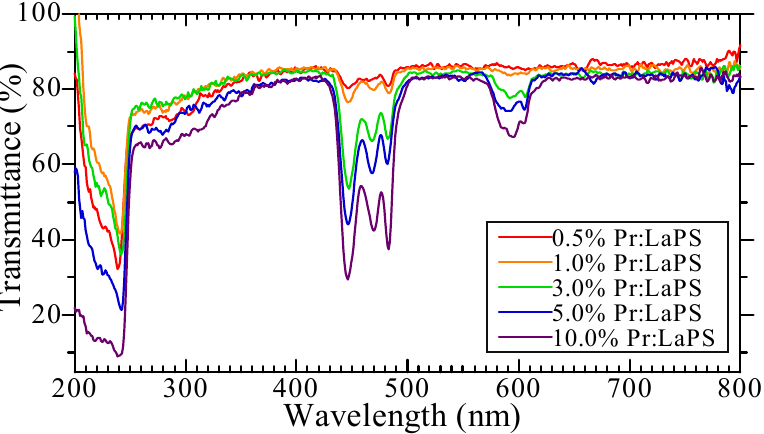
Figure 3. Transmittance spectra of Pr-doped LaPS samples.